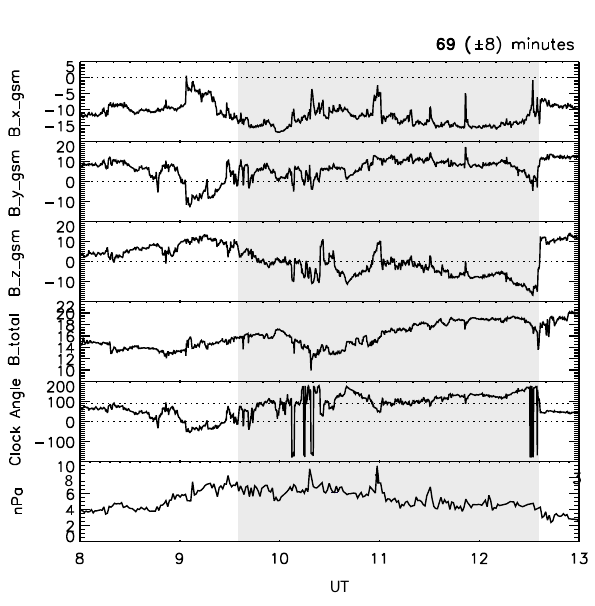
Fig. 1. The interplanetary magnetic field components, Bx , By , and Bz in GSM coordinates along with the corresponding clock angle and solar wind dynamic pressure, measured by the ACE spacecraft. The measurement was made during a 5-h interval on 5 February 2002. Highlighted in grey is the period when the transpolar arc was